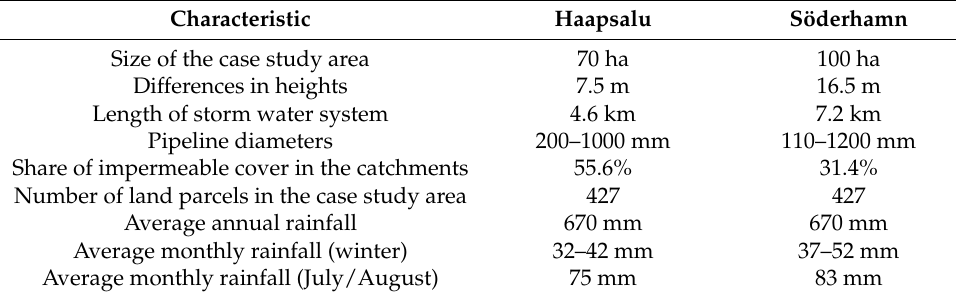
Table 1. Key characteristics of the case study areas.